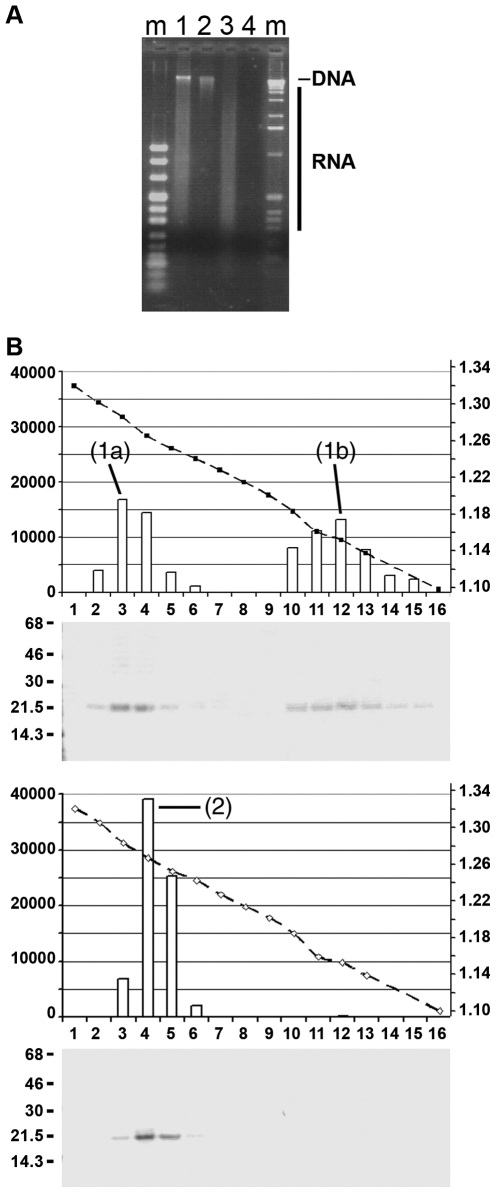
Effect of RNase A treatment of Digitonin-permeabilized cells on Mat-C migration.A. Control of RNase A treatment by ethidium bromide staining after agarose gel electrophoresis. m: marker, 1: cells not treated with nucleases, 2: RNase A-treated cells, 3: DNase I-treated, 4: RNase A and DNase I-treated cells. The Figure shows that RNase A-treatment degraded the cellular RNA completely. B. Effect of RNase A-treatment on P-Mat-C migration on Nycodenz gradients. Upper panels: RNase A-treated cells, lower panels: as in the upper panels but upon inhibition of nuclear import by WGA. For legend see Fig. 2A–C. The figures show that RNase A-treatment results in two peaks at 1.285 g/ml (1a) and 1.156 g/ml (1b). The low density peak exhibited the same density as urea disintegrated core proteins (Fig. 1B (3)). The high density peak showed a similar migration as Mat-C after nuclear import with the same peak density but with a broader range. When import was blocked P-Mat-C showed a migration with a peak at 1.266 g/ml (2) as P-Mat-C that was not exposed to cells (Fig. 1B peak (2)).